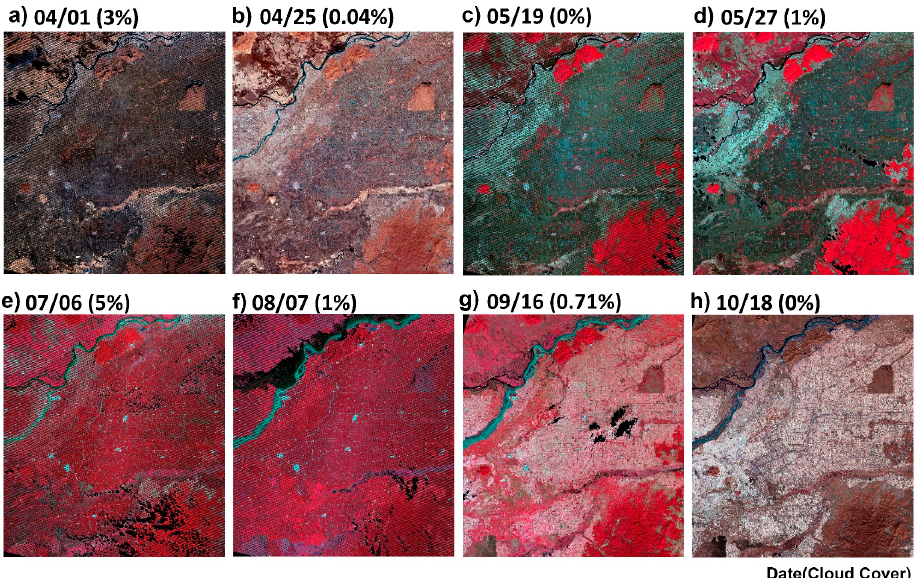
Figure 3. Landsat images used in study after preprocessing (NIR, red and green bands) on the ( a ) April 1st, ( b ) April 25th, ( c ) May 19th, ( d ) May 27th, ( e ) July 6th, ( f ) August 7th, ( g ) September 16th, and h ) October 18th, and the cloud cover percentage of each image is shown in the